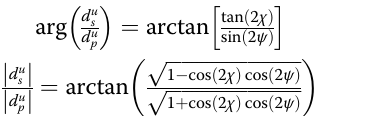
Fig. 5f. Figure 5g plots the distribution of upward far- fi eld polarization states, and circular polarization states occur at every point in the vicinity of BIC due to the specially